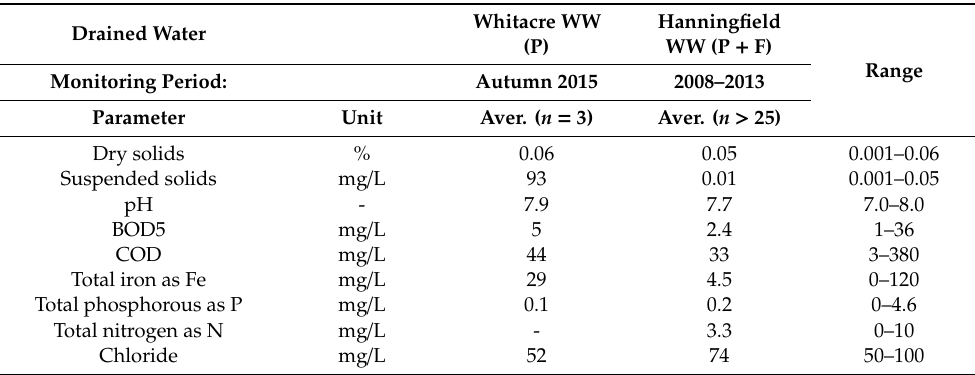
Table 5. Drained water characteristics in STRB at the Whitacre and Hanningfield WW (England) (P = pilot, F = full-scale, WW = Water Works, BOD5 = Biochemical Oxygen Demand, COD = Chemical Oxygen Demand)